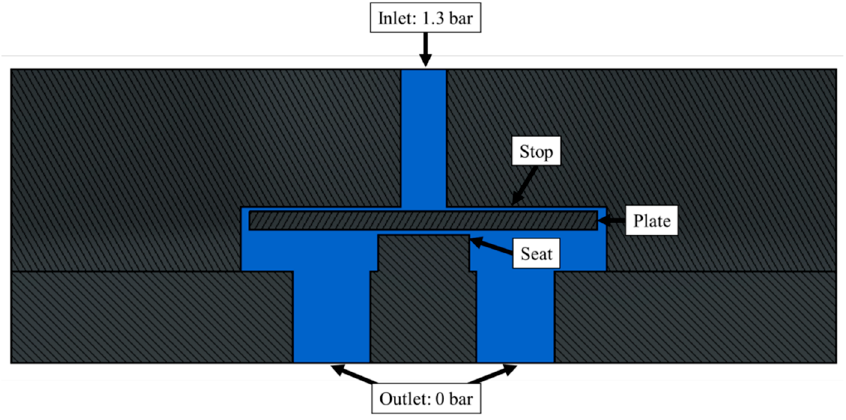
Figure 10. Computational domain generated from the internal fluid and boundary condition for the real-case analysis.